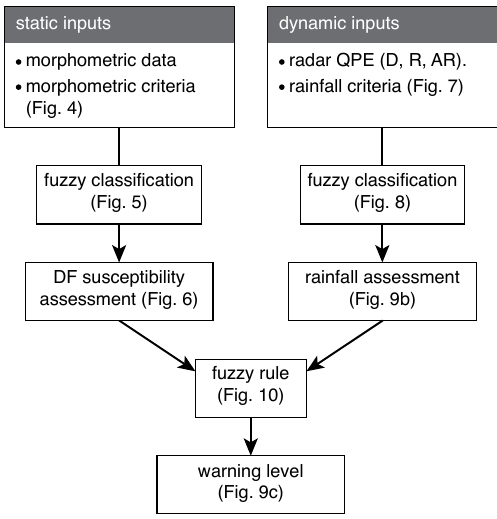
Figure 3. Schematic diagram of the proposed technique for DF warning at subbasin